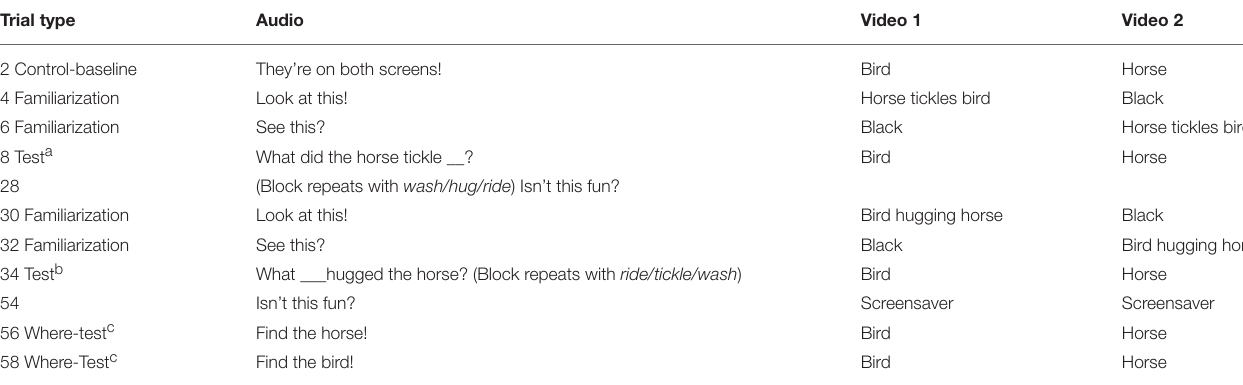
TABLE 2 | Sample layout of the Wh-question video.